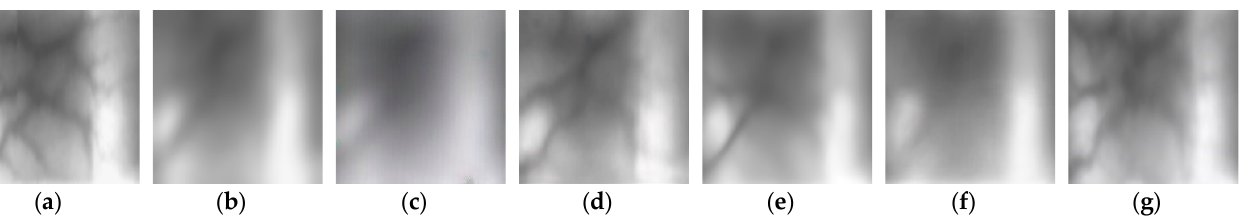
Figure 24. Examples of restored PolyU-DB finger-vein images using state-of-the-art methods and the proposed RMOBF-Net (motion blur with Gaussian blur filter of 11 × 11): ( a ) original image, ( b ) blurred image and images restored by ( c ) DeblurGAN, ( d ) DeblurGANv2, ( e ) SRN-DeblurNet, ( f ) MPRNet, and ( g ) RMOBF-Net.